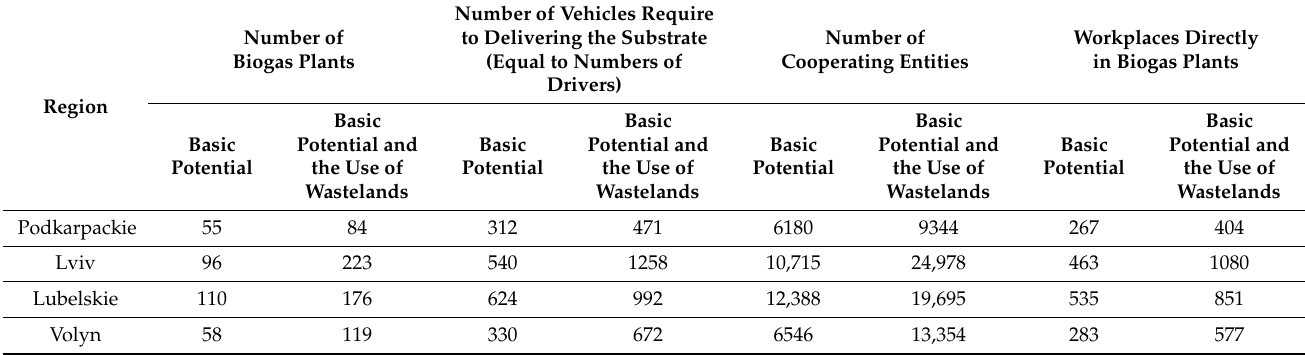
Table 6. The impact of biogas plants at a regional scale. Source: Own study.